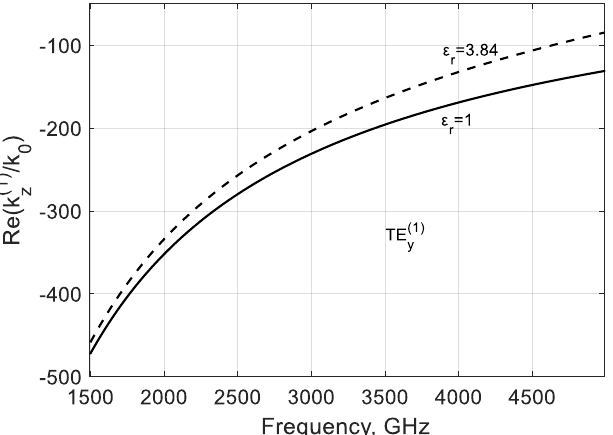
( 1 ) z / k 0 of the backward = 0.01 mm, width 2 a = ∞ , σ g are from Ref. [21]: T = 300 K,